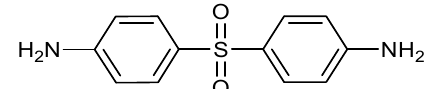
(cid:48) -diaminodiphenyl sulfone